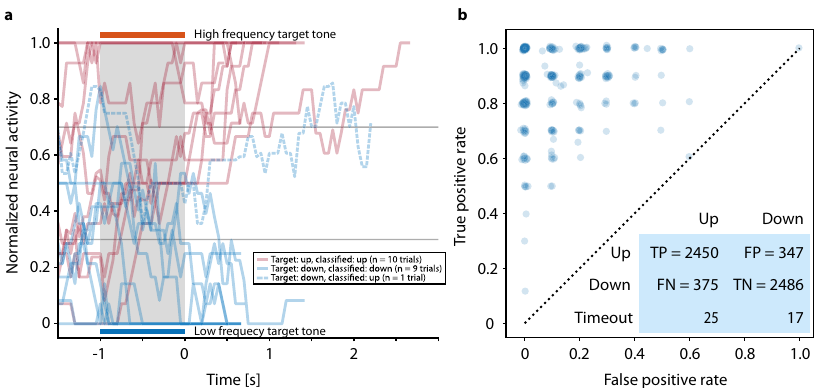
Fig. 2 Neurofeedback task and classi fi cation. a Representative example for normalized and mixed fi ring rate during ten high (red) and ten low (blue) target tone frequency feedback trials of day 247. The patient was asked to match the target tone by modulating the normalized and weighted fi ring rate, and he succeeded in all but one trial of this example. Trials were completed as soon as the fi ring rate was held above or below the upper or lower threshold, respectively. As de fi ned in the Materials and Methods section, these feedback blocks were performed every day of recording for training, parameter selection, and validation of the selected parameters. The grey-shaded region from − 1 to 0 s depicts the time period during which the high or low target tones were presented to the patient. The horizontal line at 0.3 and 0.7 shows the lower and upper threshold, respectively. Source data are provided as a Source Data fi le. b True positive rate vs. false positive rate of the trials in auditory neurofeedback blocks directly preceding speller blocks on days 123 – 462. Each circle represents one neurofeedback block; circles are jittered for better visibility. The blue insert at the bottom right corner shows the contingency table of all neurofeedback trials directly preceding speller blocks on days 123 – 462. In the blue insert — TP stands for true positive, i.e., up trials classi fi ed as up; FP stands for false positive, i.e, up trials classi fi ed as down; FN — stands for false negative, i.e., down trials classi fi ed as up; TN — stands for true negative, i.e., down trials classi fi ed as down; Time out denotes the trials that were unclassi fi ed. Source data are provided as a Source Data fi